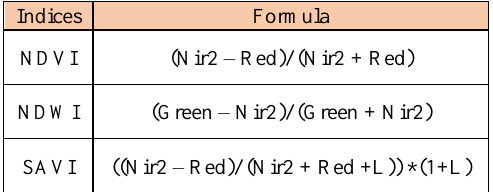
Figure 5. Classes and sub-classes used for classification and validation of results.